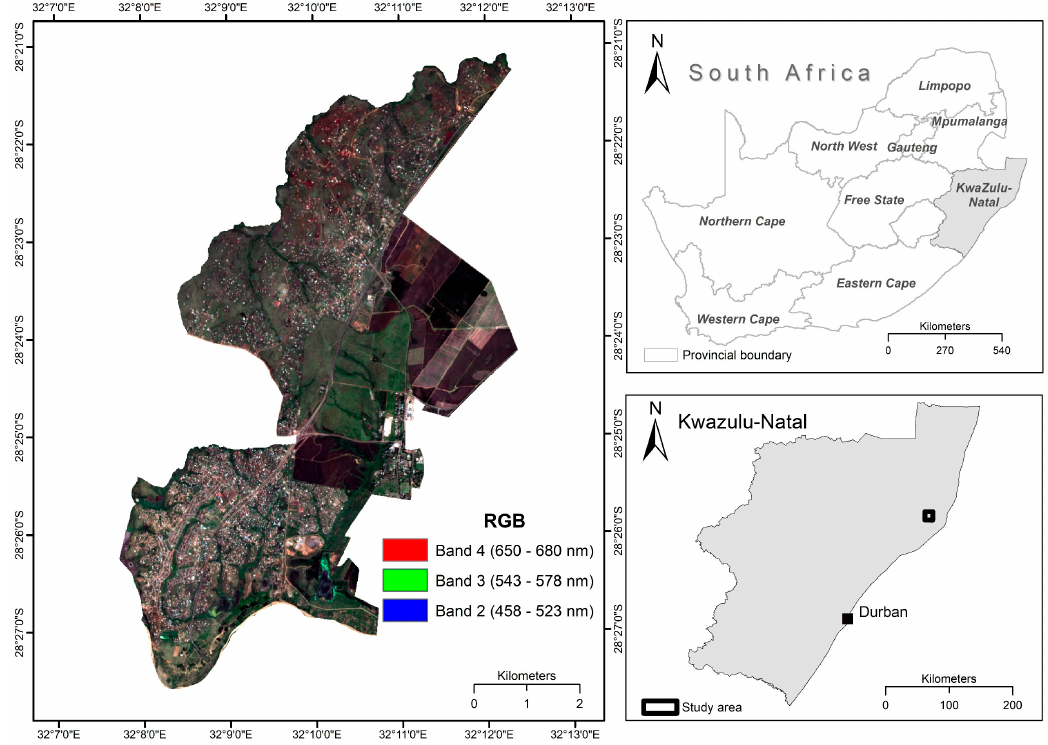
Figure 1. Location of the study